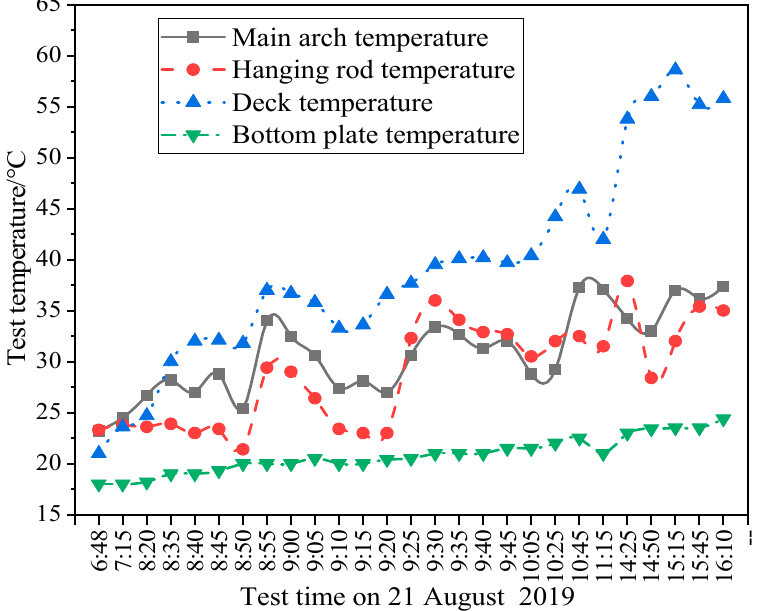
Figure 11. Monitored temperature field at different times.